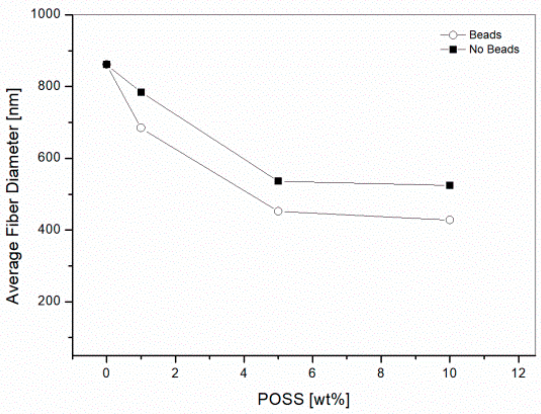
Figure 6. Average fiber diameter for the veil with 10 wt % POSS when excluding the beads from the